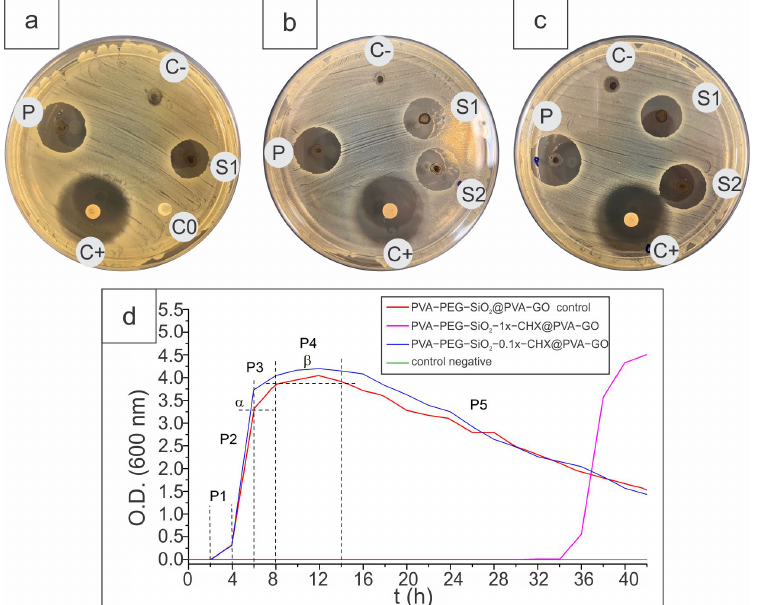
Figure 11. Disc diffusion assays of core–shell fibers ( a – c ), where PVA-PEG-SiO 2 @PVA-GO (C-); PVA- PEG-SiO 2 -1x-CHX@PVA-GO (S1, S2), PVA-PEG-1x-CHX@PVA-GO (P), cellulose disk (C0); cellulose control with doxycycline (C+) against S. aureus ; ( d ) antibacterial activity of CHX-loaded core–shell PVA-PEG-SiO 2 -1x-CHX@PVA-GO and PVA-PEG-SiO 2